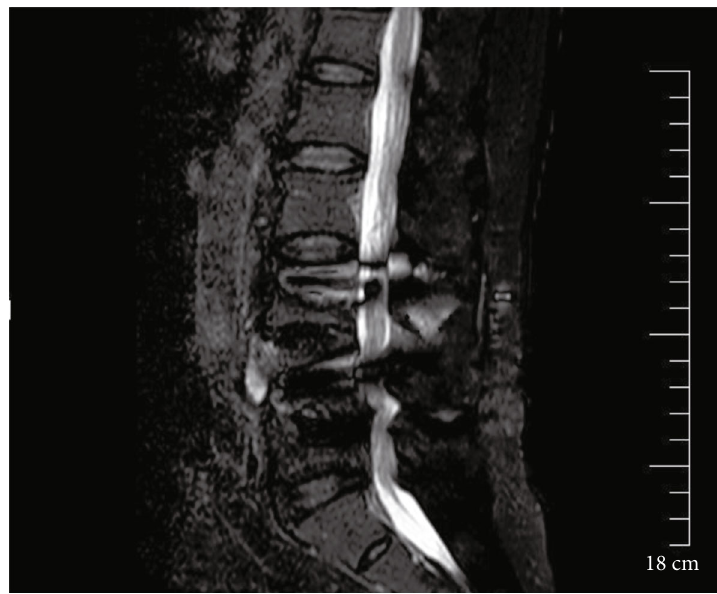
Figure 3: Preoperative MRI of the fourth and fi fth lumbar